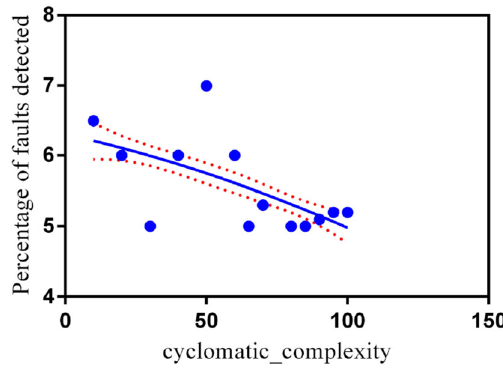
Fig. 12 Complexity-fault analysis of BITCP (Spearman r s = − 0 . 48)